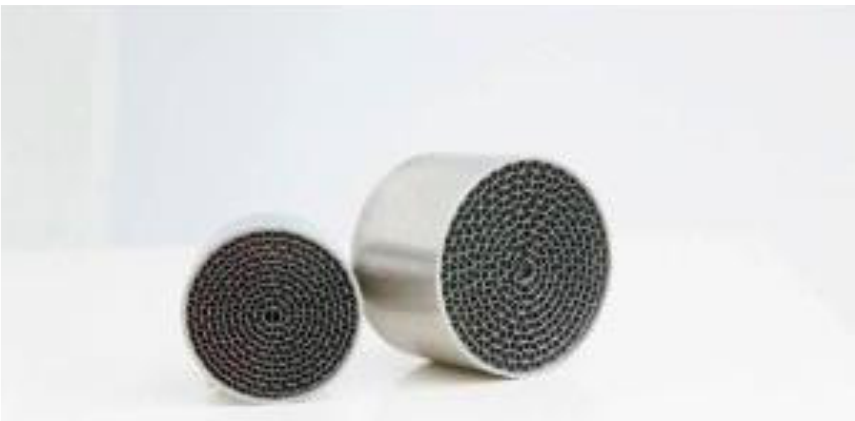
Figure 5. Stainless honeycomb monolith [81].